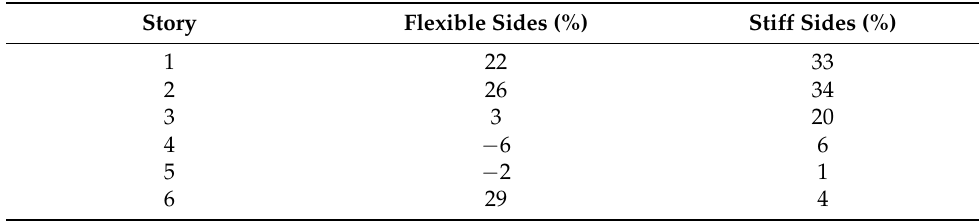
Figure 18. Mean plastic chord rotations θ pl,3 (rad) of the beams’ end-sections at: ( a ) the flexible sides and ( b ) the stiff sides of the case 2 building resulted by the “inelastic dynamic eccentricities” pushover procedure at the NC state. Table 8. Error (%) on the mean seismic plastic chord rotations of the beams’ end-sections at the flexible and stiff sides of the case 2 building resulted by the “inelastic dynamic eccentricities” pushover procedure at the NC state.